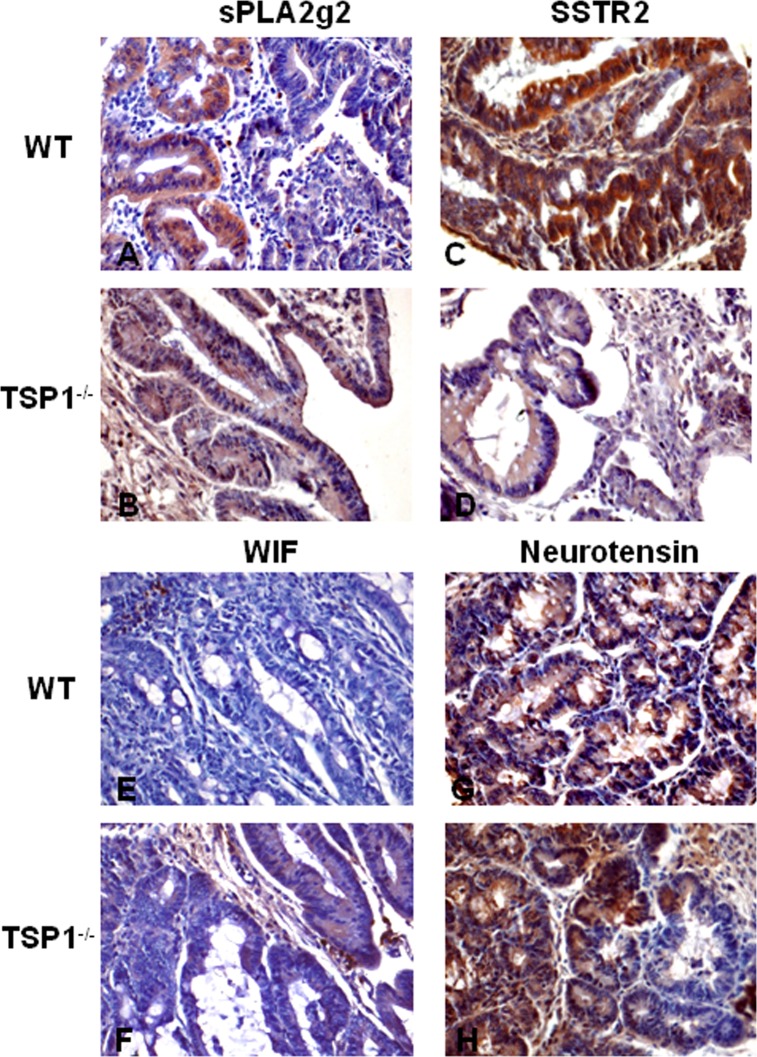
Validation of transcripts involved in inflammation and cancer by IHC.The expression of some transcripts involved in epithelial proliferation and the immune response was examined by IHC. PLA2g2 immunostaining of these tumors showed a focal localization in glands of WT tumors (A). This same protein was diffusely expressed in the glands and stroma of TSP-1-/- tumors (B). SSTR2 was intensely expressed in WT tumors (C) while the staining in TSP-1-/- lesions was rather light or even negative (D). WIF1 was focally located in the lamina propria of WT cancers (E). Cytoplasmic staining was detected in isolated foci of cells in malignant glands in TSP-1-/- tumors (F). Neurotensin (NTS) was predominantly localized in the malignant epithelial cells. While WT tumors showed intense and diffuse staining (G), some of the tumors developed in TSP-1-/- showed focal areas lacking NTS staining (H).